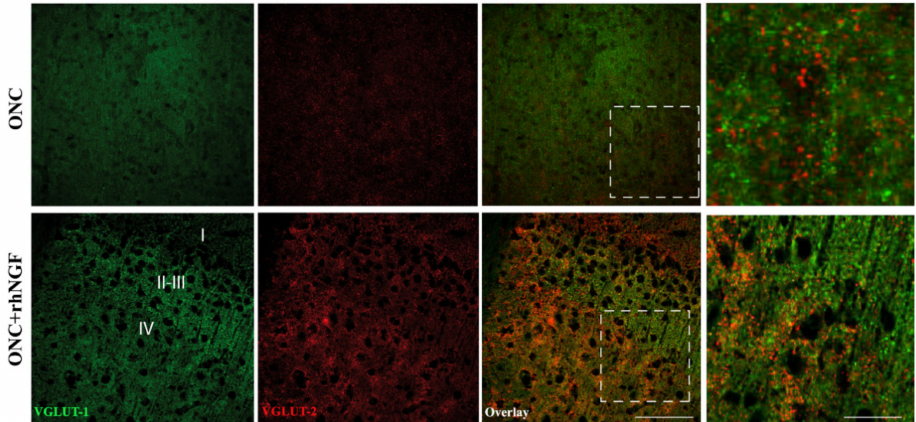
Figure 2. Shows representative VGLUT-1 and VGLUT-2 immunofluorescent staining in the VCx (layers I-IV) of rats. Low magnification of VGLUT-1 (green) and VGLUT-2 (red) in cortical layers I–IV of contralateral visual cortex shows a prevalent VGLUT-1 and a weakly VGLUT-2 staining in cortical varicosities of ONC brains, apparent in the inlet (dotted lines). Ed-rhNGF treatment led to increased positivity of neuronal varicosities to both glutamate transporters in all the ONC cortical layers examined and particularly to VGLUT-1 in layers I–III and VGLUT-2 in layer IV, as more evident in the inlets (scale bars: 200 mm; inlet: 50